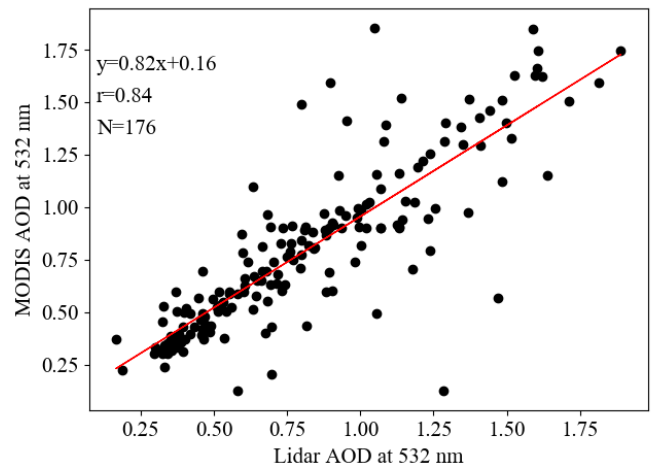
Figure 4. Correlation between the ground-based Lidar AOD and 1 km resolution MODIS AOD at the site of Southwest Jiao-tong University.